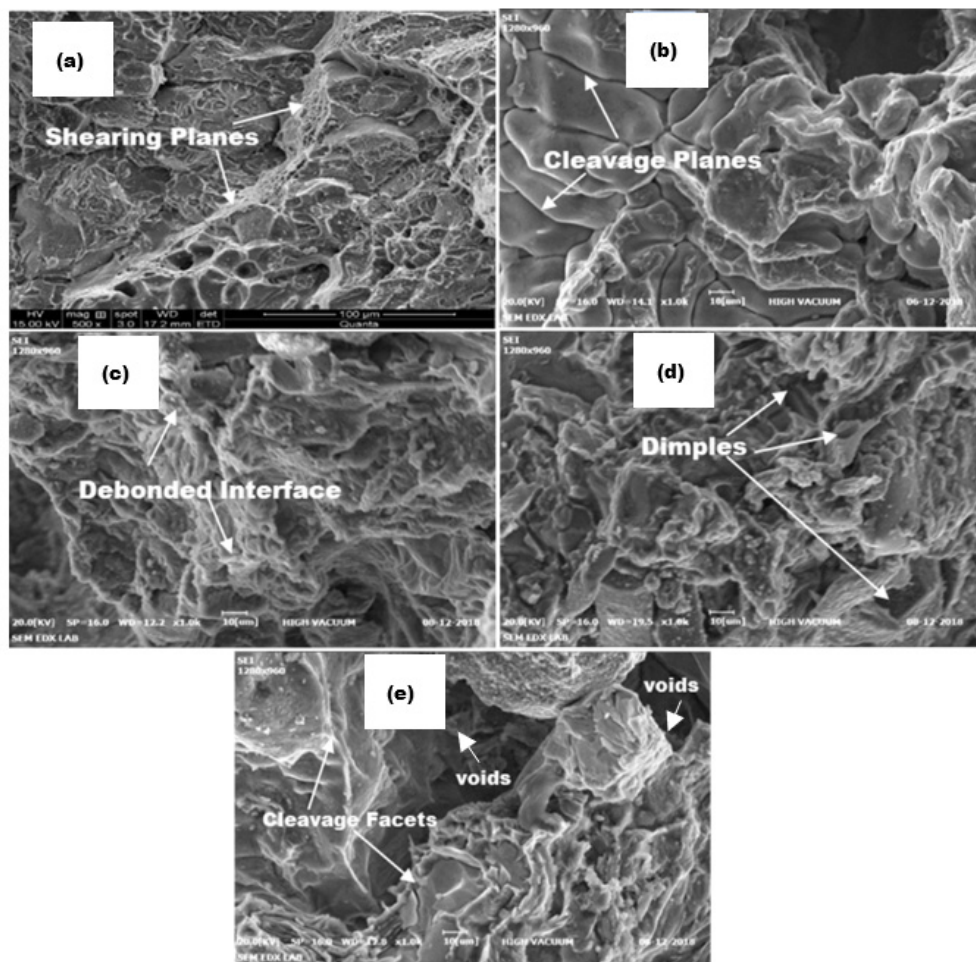
Figure 7. SEM images of the tensile-fractured surfaces of Al6061-TiC MMCs: ( a ) Al6061 base alloy; ( b ) Al6061-2 wt.% TiC; ( c ) Al6061-4 wt.% TiC; ( d ) Al6061-6 wt.% TiC; and ( e ) Al6061-8 wt.% TiC MMCs.